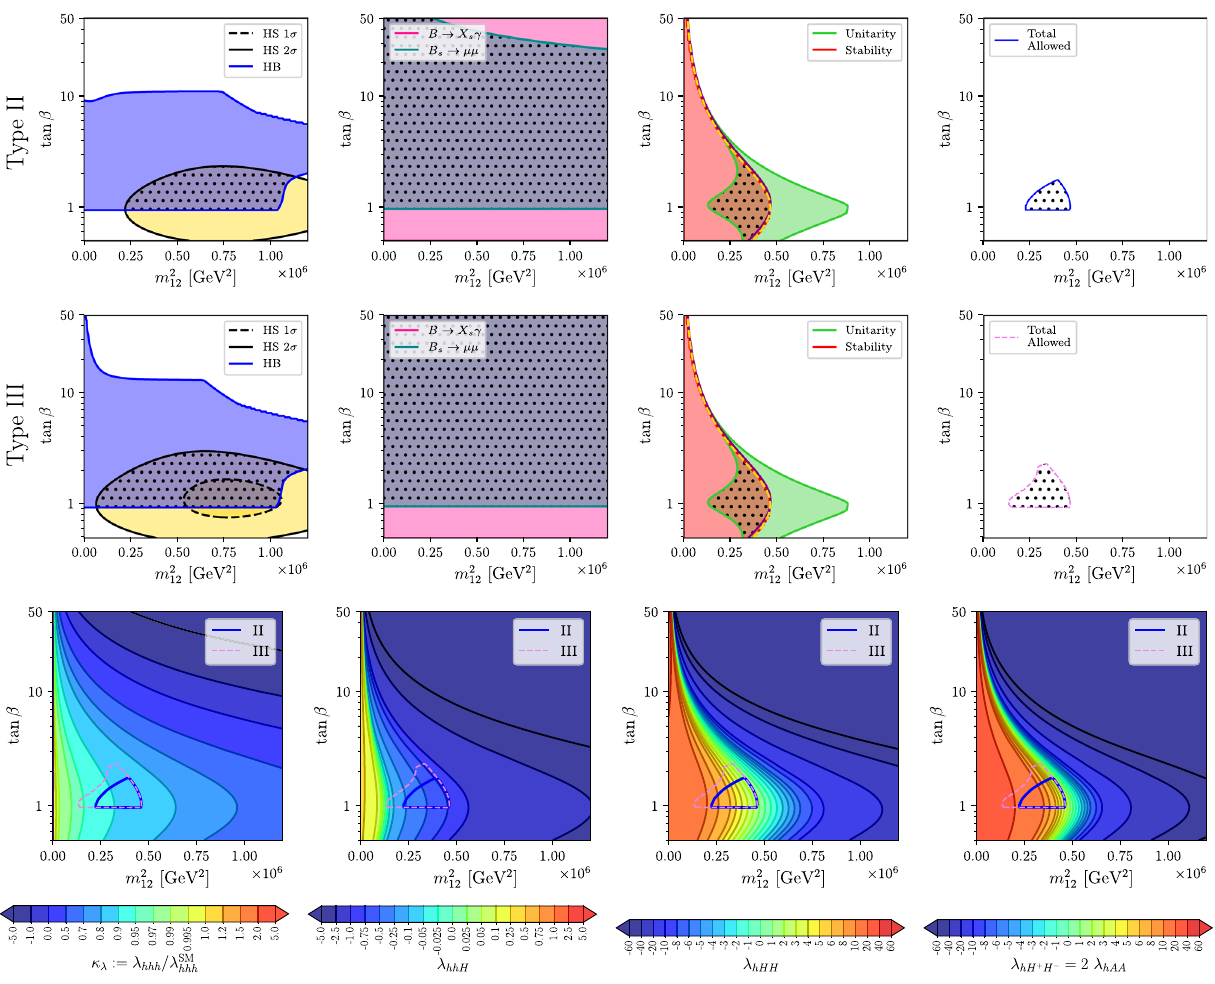
Fig. 11 Allowed areas (dotted regions) from the various constraints (upper row) and triple Higgs couplings (lower row) for the benchmark scenario II/III-4 in the m 2 –tan β plane with m ≡ m H = m A = m H ± = 1000 GeV and c β − α = − 0 . 12